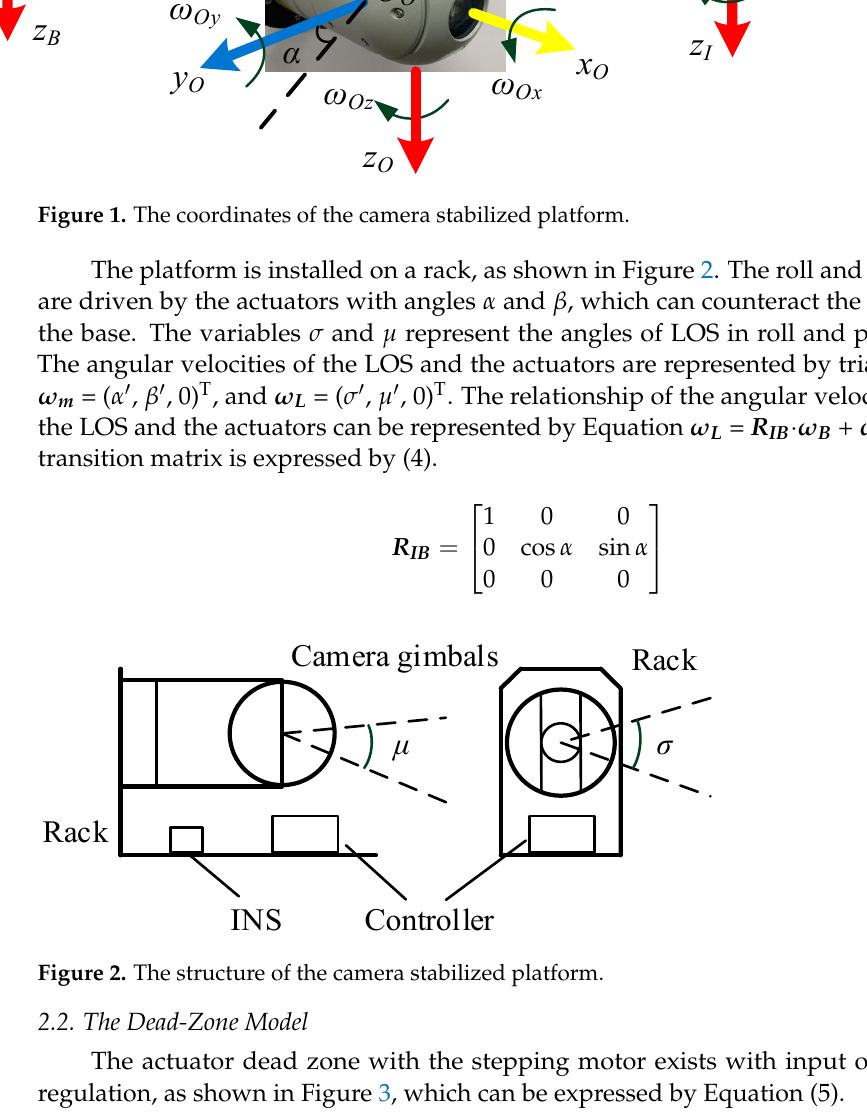
Figure 2. The structure of the camera stabilized platform.